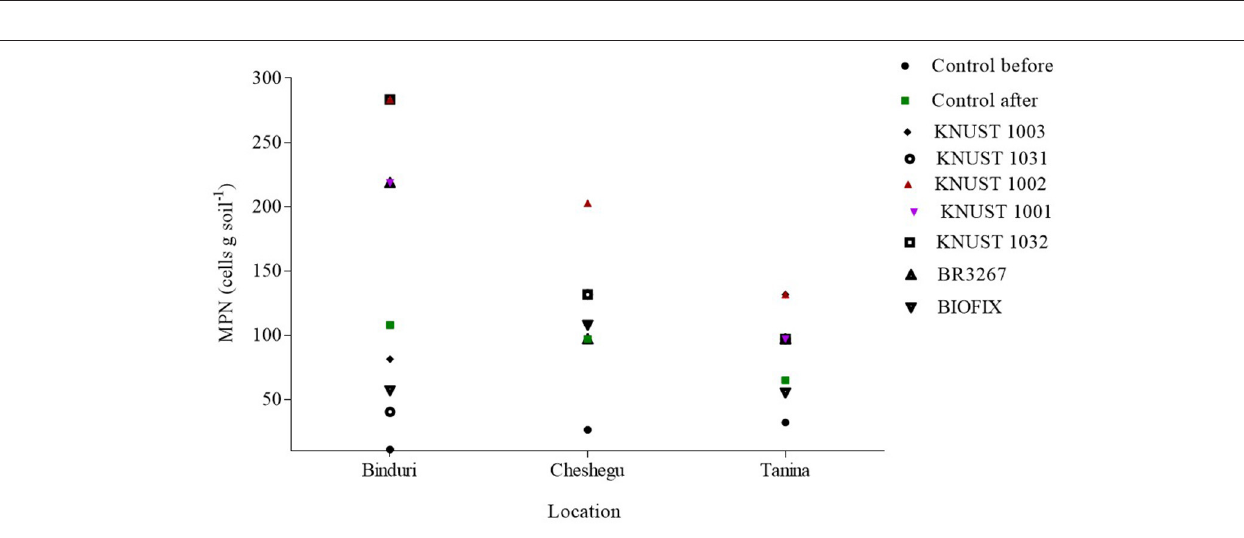
has shown the potential of strains KNUST 1002,